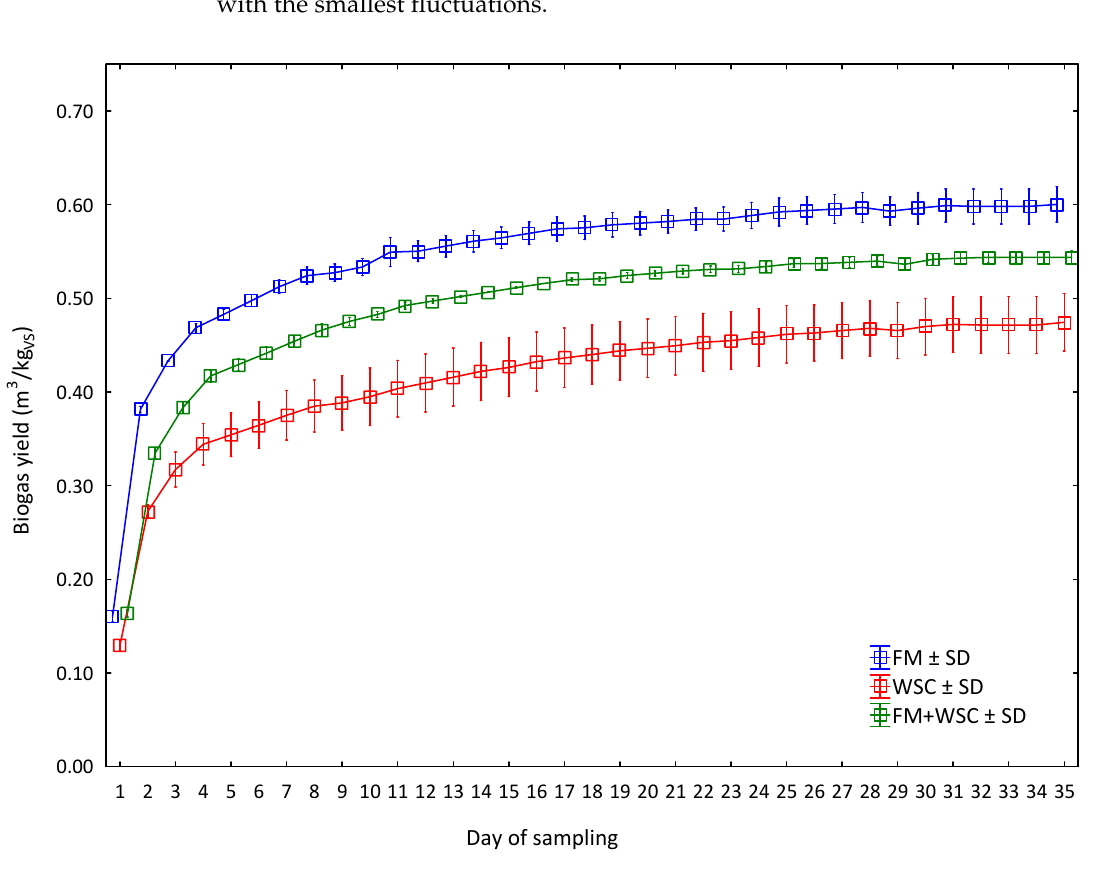
Legend to Table 7: Different small letters illustrate demonstrable differences between the respec- tive experimental treatments at a level of significance p < 0.05. FM—fodder mallow, WSC—white sweet clover.